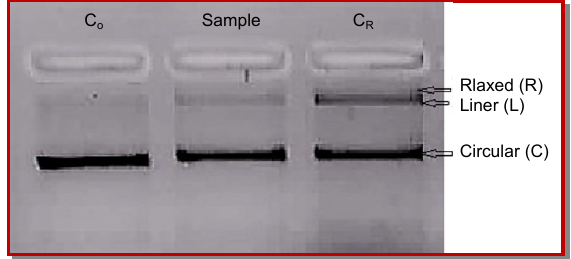
Figure 2: Effect of anti- cancer activity (50 µg) against oxidative to 46966 plasmid DNA damage caused by UV-photolysis of H 2 O 2 (3%, v/v) C 0 = untreated non-irradiated DNA; Sample = DNA UV- irradiated treated with n -butanol extract of P. coronopifolia; C R = untreated UV-irradiated DNA